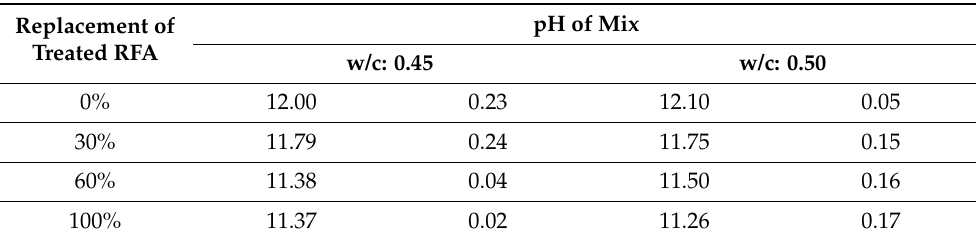
Table 5. pH values of the mortar mixes with different replacement of treated RFA at 0.5 mol/L–7d–20 °C.